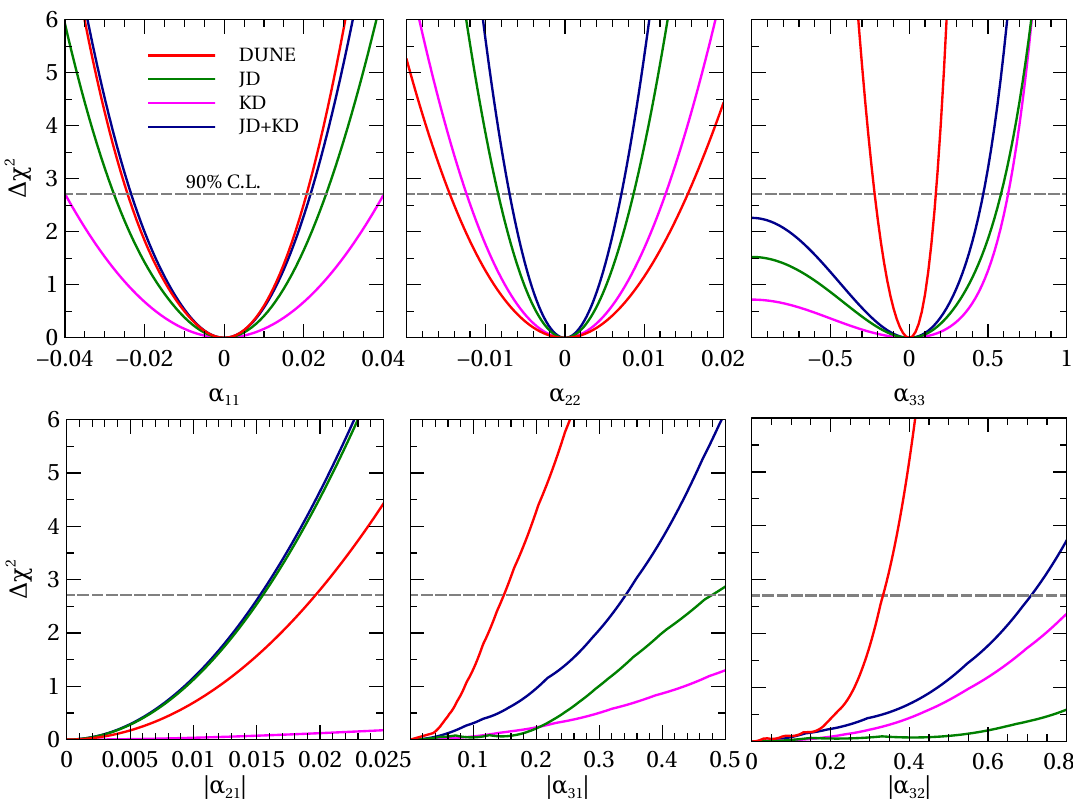
Figure 6 . Expected limits on the NUNM parameters from DUNE (red curves), JD (green curves), KD (magenta curves), and JD+KD (blue curves). The upper (lower) panels are for the diagonal (off-diagonal) NUNM parameters one at a time. True values of θ respectively. For the diagonal NUNM parameters, we marginalize over θ and δ in the range [ − 180 ◦ , 180 ◦ ] in the fit. For the off-diagonal NUNM parameters, apart from CP θ 23 and δ CP , we also marginalize over the associated NUNM phases in the range of − 180 ◦ to 180 ◦